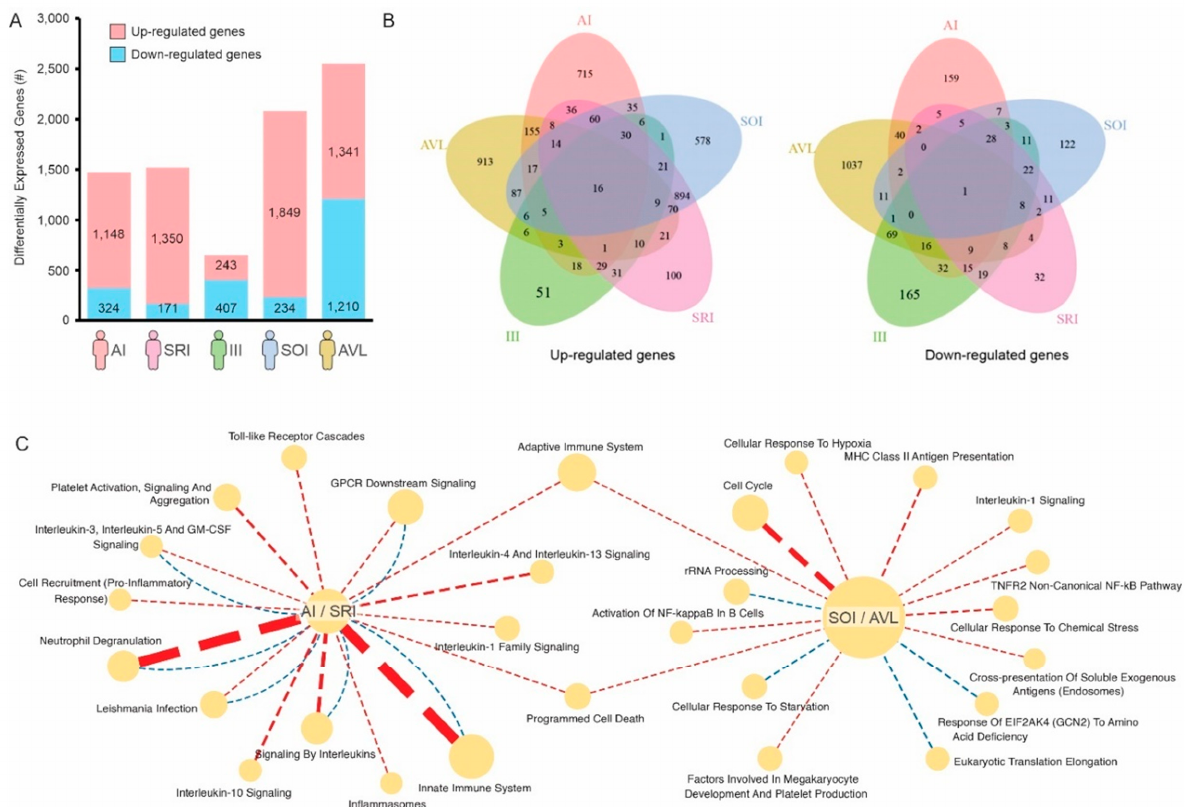
Figure 2. Gene signatures associated with individuals infected with L. ( L. ) chagasi . ( A ) Number of genes up- (red) or down-regulated (blue) on each group of infected individuals compared to healthy controls. ( B ) Venn diagram showing the number of genes shared by the different groups. ( C ) Reactome pathways specifically associated with individuals with AI/SRI (asymptomatic) profiles or SOI/AVL (symptomatic) profiles. Pathways enriched with up-regulated genes are connected by red dashed lines, whereas pathways enriched with down-regulated genes are connected by blue dashed lines. The thickness of the lines is proportional to the enrichment − log 10 p